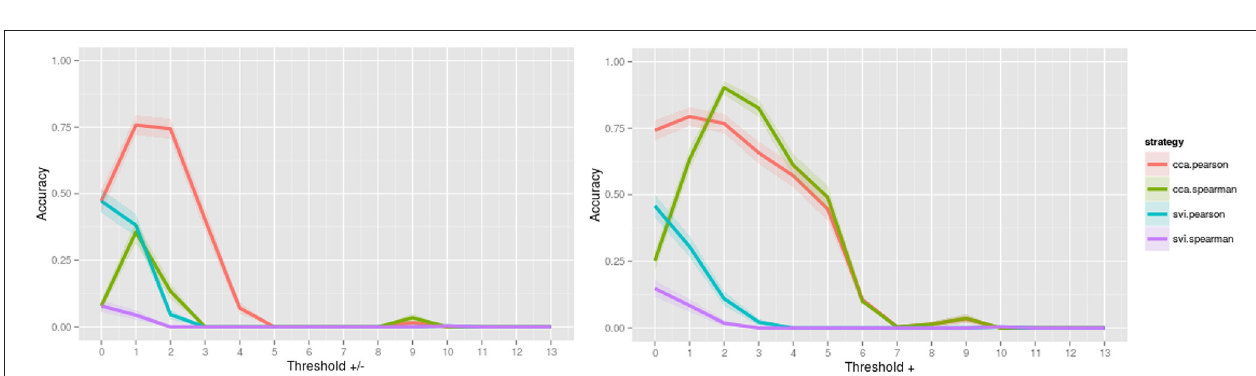
Frontiers in Neuroscience |